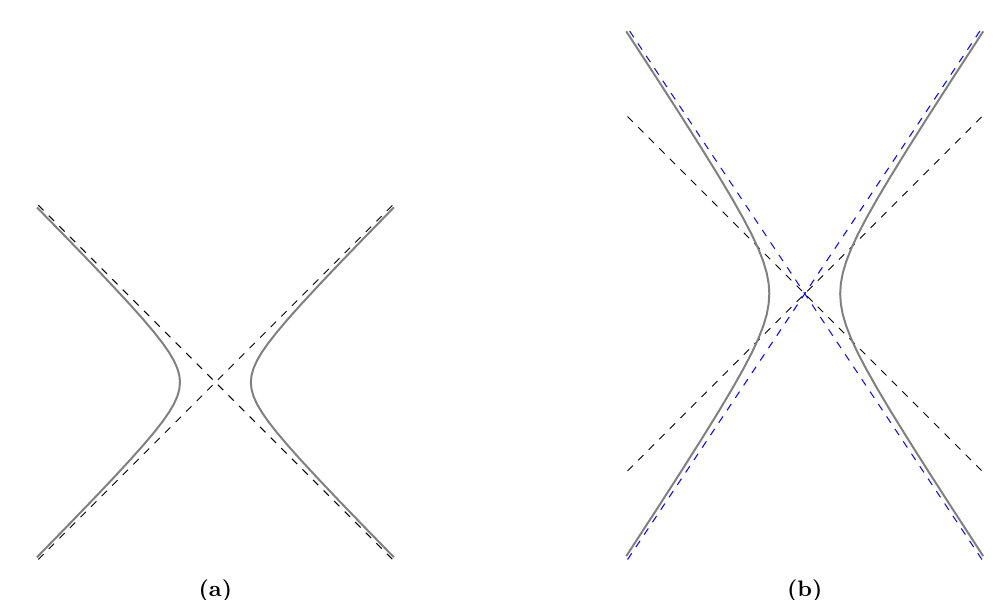
Figure 12. (a) The Wick rotation of a circle, giving the edge trajectories when the path integral has a disk of CFT1. The edge trajectories asymptote to the light rays passing through the origin. The left CFT is behind a horizon from the perspective of the right CFT. (b) The Wick rotation of an ellipse which has been stretched in the τ direction. The edge trajectories now asymptote to timelike lines. The left and right CFTs are now causally connected via the intermediate CFT1